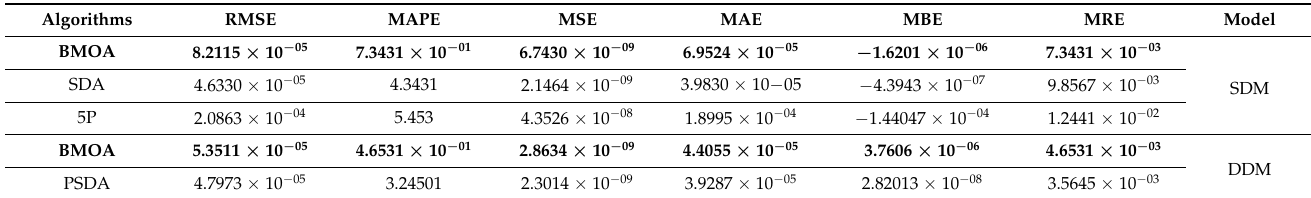
Table 7. Amorphous silicon photovoltaic cell (SDM and DDM) statistical Table 8. (I, V) points of RTC silicon photovoltaic cell.